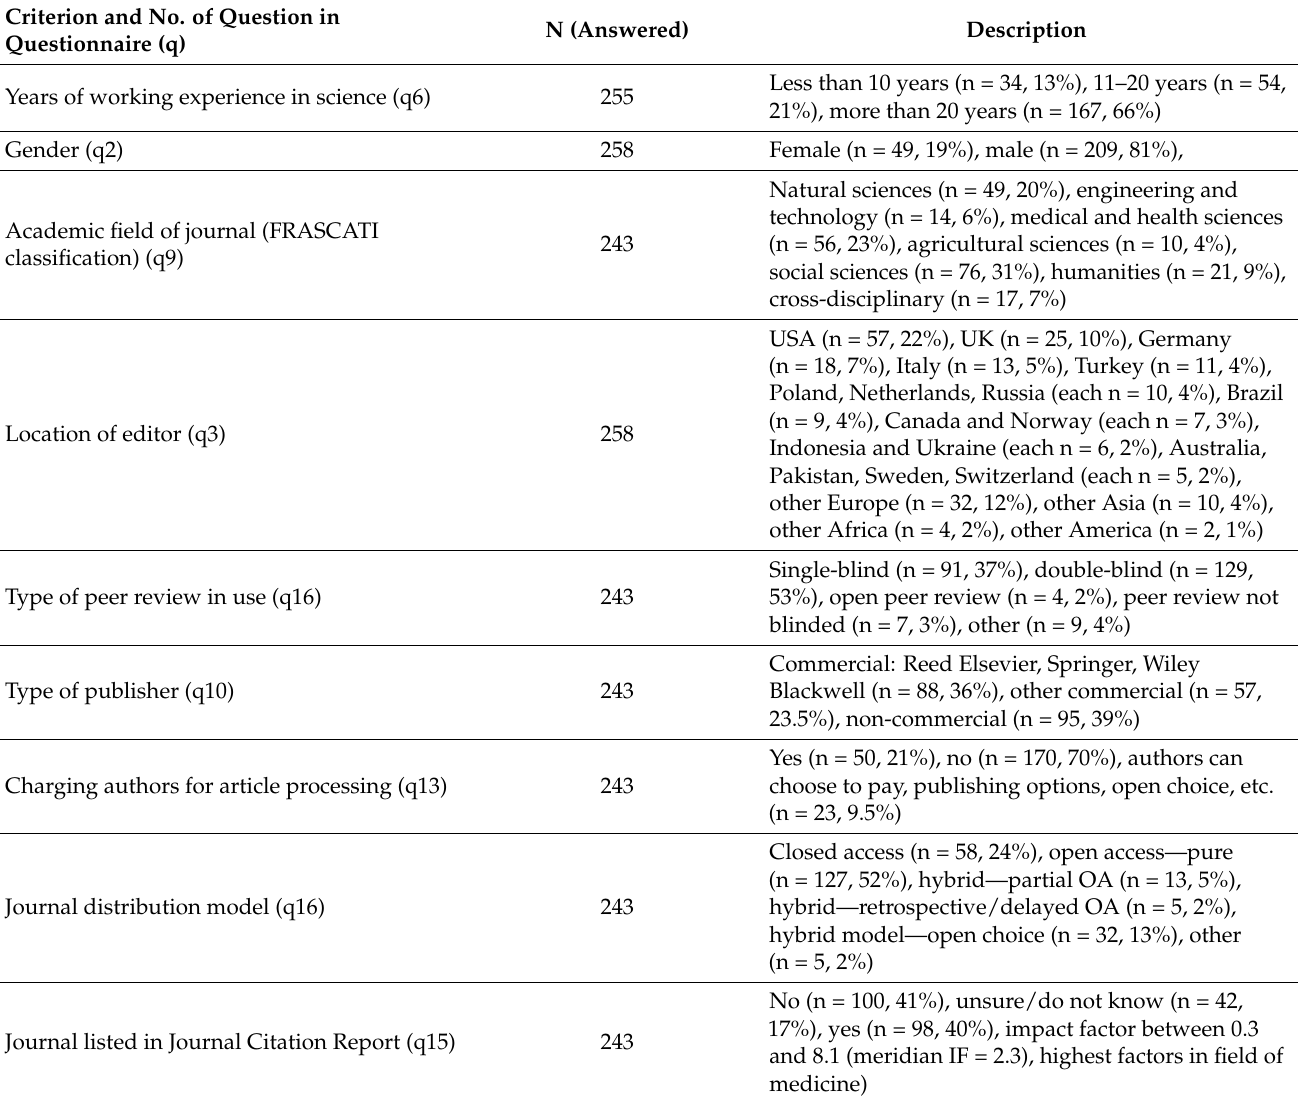
Table 1. Respondent